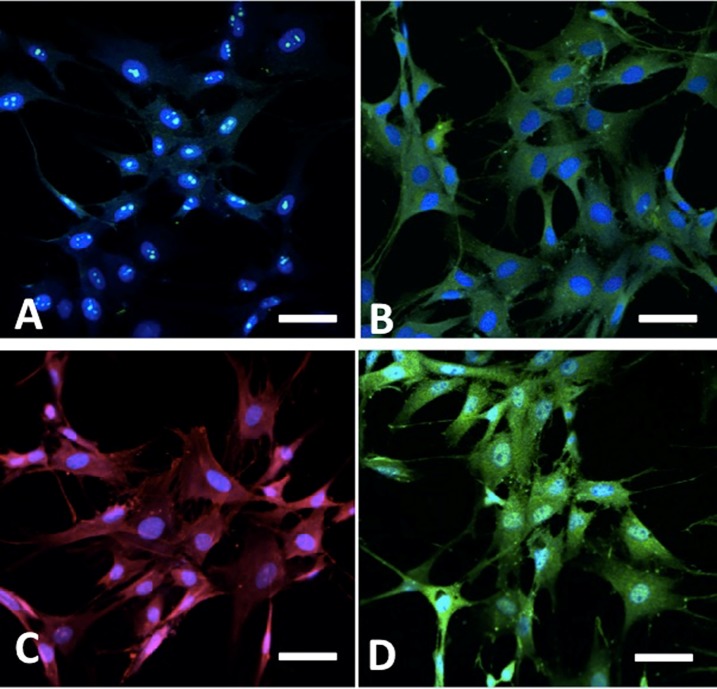
Immunofluorescent staining of Nucleostemin (A, green), CD44 (B, green), SSEA4 (C, red) and CD90 (D, green) in P3 TSCs.All scale bars = 25 μm.